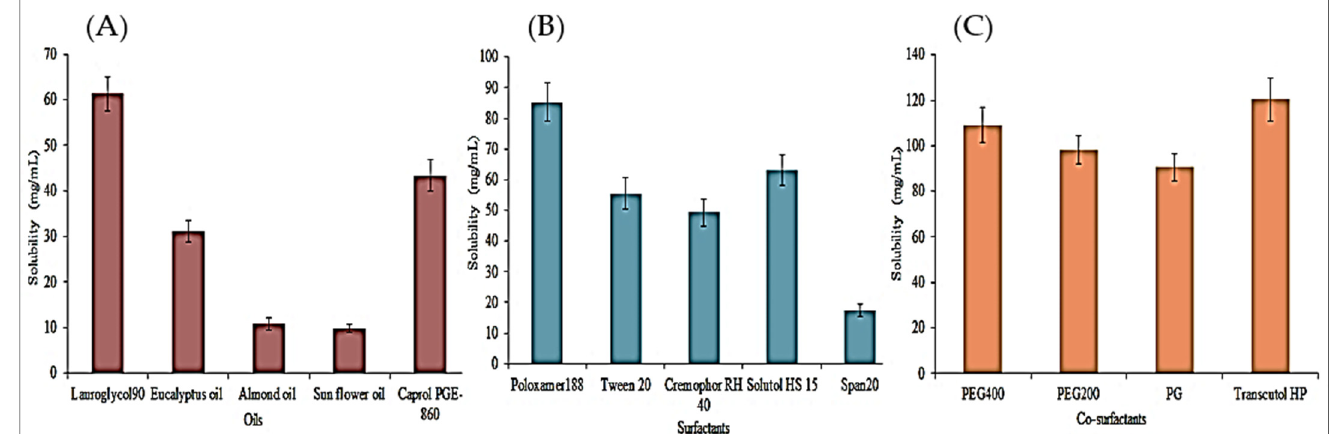
Figure 1. Solubility data of CEP in different oils ( A ), surfactants ( B ) and co-surfactants ( C ). Study performed in triplicate and results shown as mean ± SD.